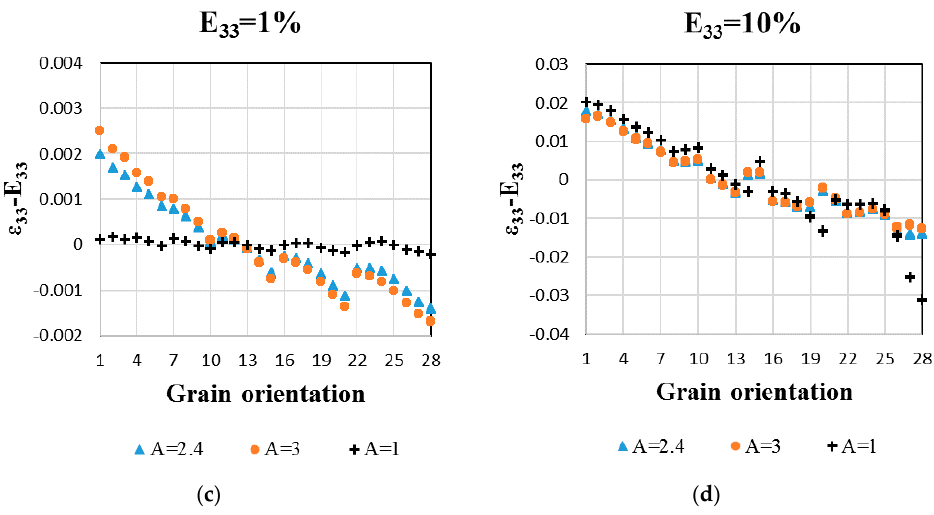
Figure 5. Incompatibility stresses ( a , b ) and incompatibility strains ( c , d ) (dimensionless) for grain orientations 1 to 28 at 1% and 10% macroscopic strains. The applied strain rate is ε(cid:4662) = 2 × 10 (cid:2879)(cid:2871) s (cid:2879)(cid:2869) . Inverse pole figure associated with the tensile axis, which defines the studied 28 grain orientations, were reported in Figure 1a.